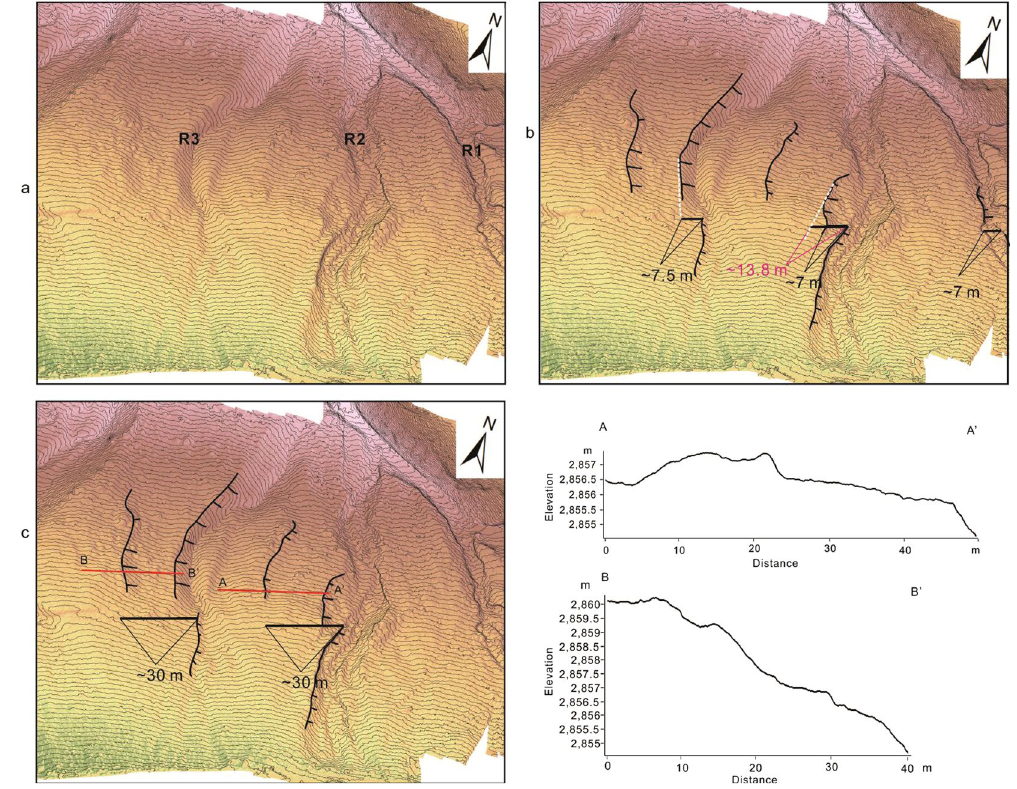
Figure 7. ( a ) Digital elevation model with contour lines (0.25 m interval) for R1, R2 and R3. ( b ) Interpretation of terrace risers and reconstruction of the ~7 m offset. ( c ) Reconstruction of the ~30 m